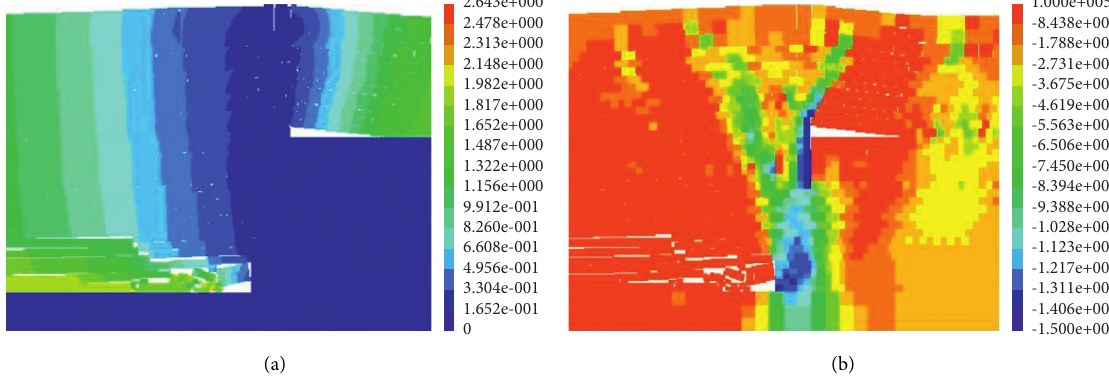
Figure 10: Evolution of displacement and stress in coal seam mining for the case where the lower coal seam is excavated with the coal face 5m from the boundary pillar of the goaf. (a) Nephogram of stope displacement. (b) Vertical stress cloud map of stope.